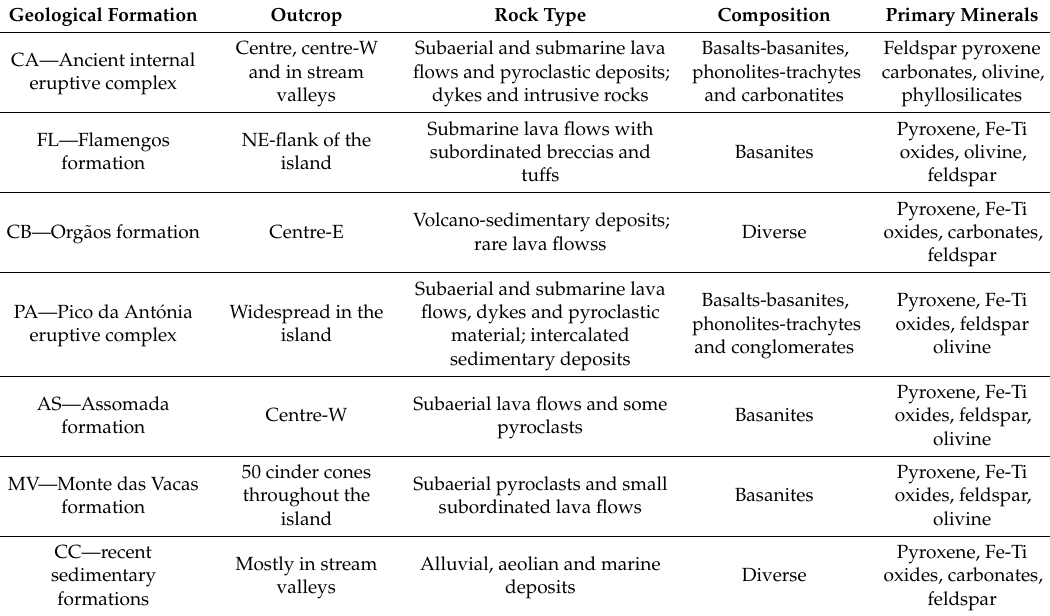
Table 1. Geologic units, outcrop, rock type and composition, primary minerals of Santiago Island, Cape